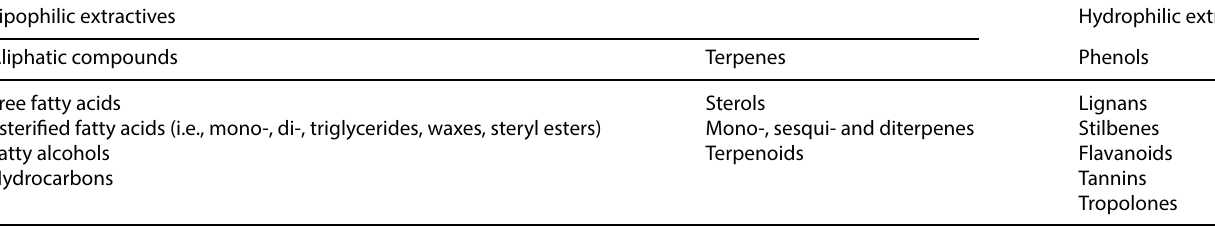
Table 2 Classification of wood extractives based on their dissolution behavior, chemical composition, and structure ( adapted from ref. [12]) Lipophilic